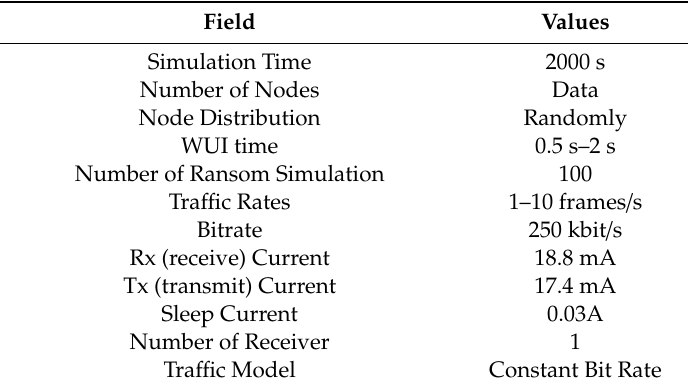
Table 2. The simulation